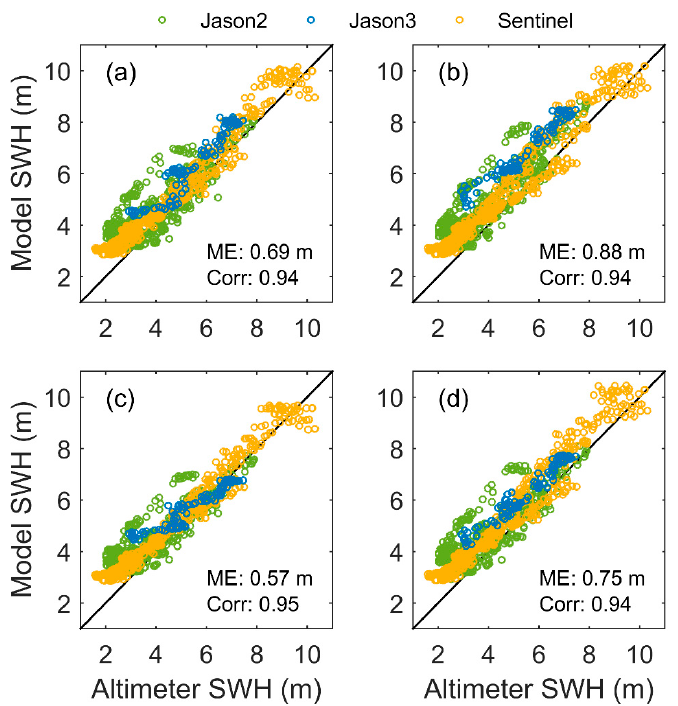
Figure 8. Typhoon Shanshan. Comparison of altimeter observed SWH with model results from experi- ments ( a ) R0, ( b ) R1, ( c ) R2, and ( d ) R3. See Table 1 for details of the different numerical experi- ments.